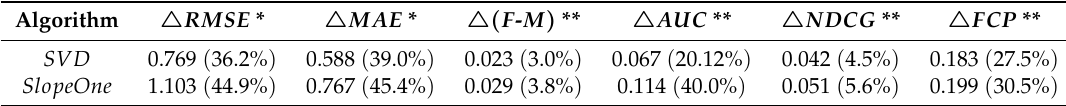
Table 11. Level of accuracy improvement between MC - Slope and the single rating